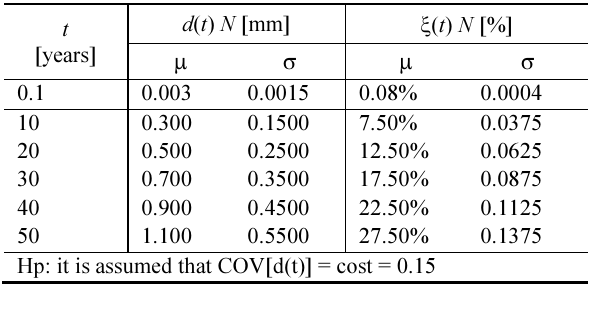
Table 3. The mean values and standard deviations of the assumed deterioration model